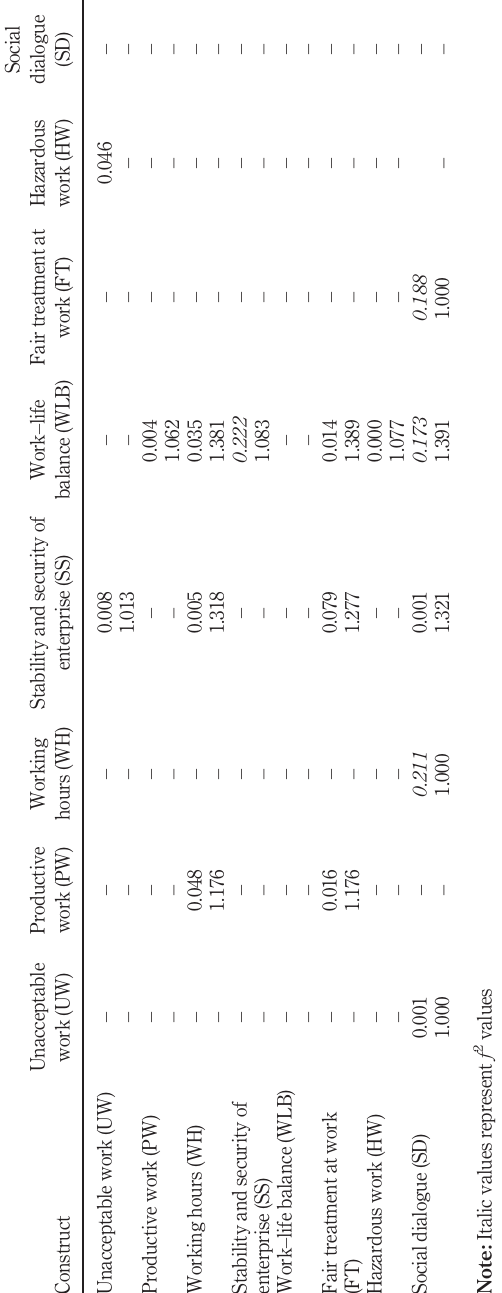
Table III. f 2 (First row) and VIF (second row) of the